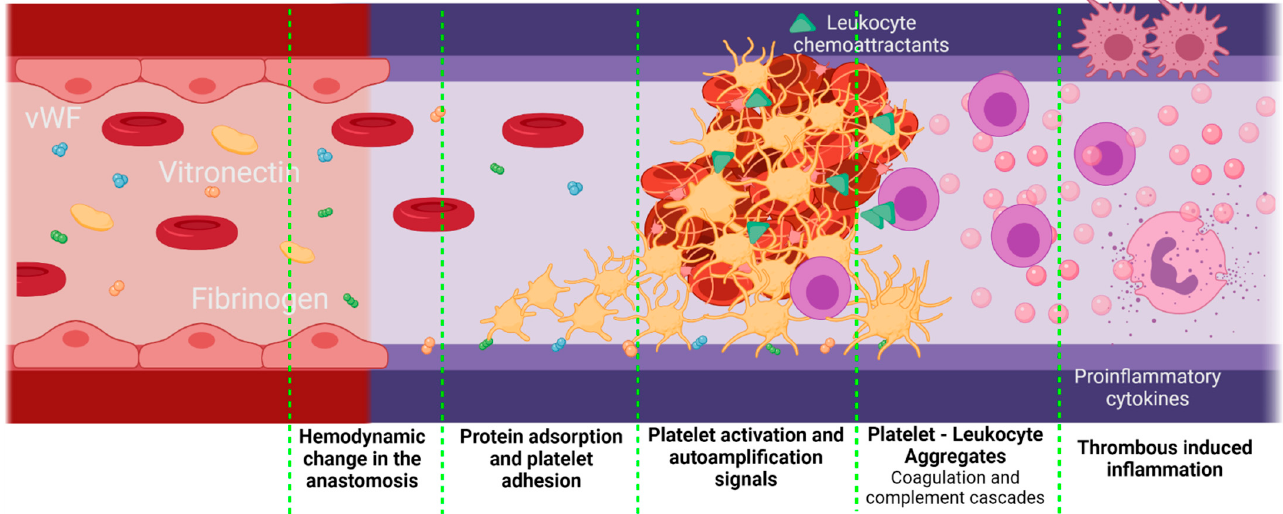
Figure 6. Proposed scheme for platelet–leukocyte aggregates generated in vascular grafts. Platelet–leukocyte aggregates might be favored if there is a significant damage of the adjacent tissues during the implantation, as well as an inadequate hemodynamic behavior of the VG with a thrombogenic surface. In this case, the first step is protein adsorption. Due to the surgery, the F3 coagulation factor will be released, activating the extrinsic coagulation pathway. On the other hand, kininogen, prekallikrein, and factor 12 (F12) will attach to negatively charged surfaces, activating the intrinsic pathway and, finally, under low shear stress conditions, vWF is unfolded, thereby interacting with the platelet receptors. Active platelets adhere to the surface of the vascular graft and promote coagulation by autoamplification mechanisms. Active platelets also release leukocyte chemoattractants and leukocyte ‐ binding proteins such as the P ‐ selectin. The leukocytes adhered through the P ‐ selectin glycoprotein ligand ‐ 1 will release a series of pro ‐ inflammatory cytokines, which enhances the inflammatory response even further (Created with BioRender.com, accessed on 7 November 2021).